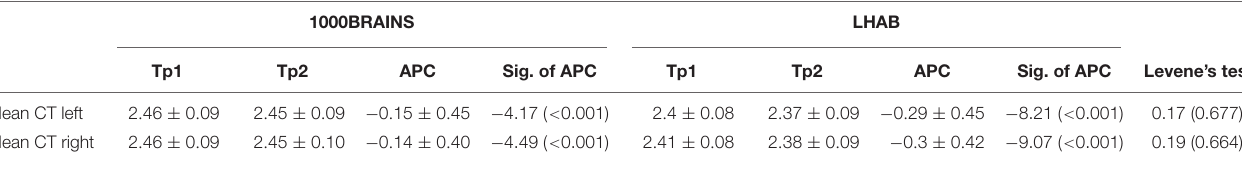
TABLE 3 | Cortical thickness values for TP1 and 2, as well as the annual percentage change (APC) together with T and p -values for the APC (Sig. of APC; one sample T -test) and F and p -values for sample homogeneity (Levene’s test).